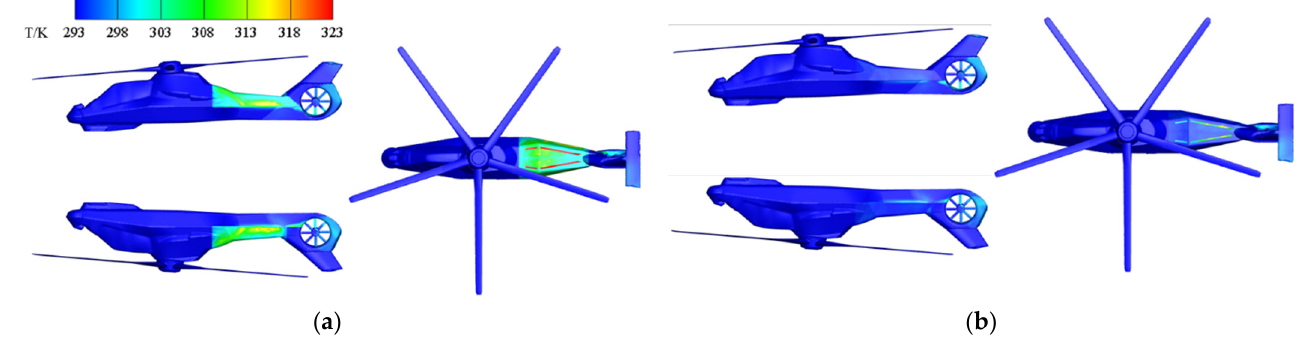
Figure 17. Temperature distribution of the fuselage surface. ( a ) Model R; and ( b ) Model R+.